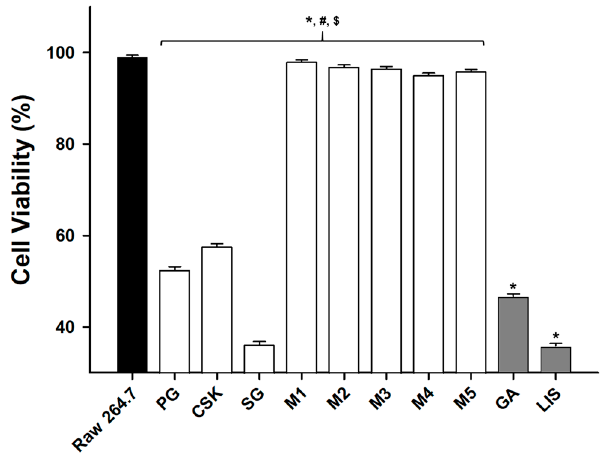
Figure 3. MTT assay statistical graph: xell viability. All experimental groups were compared with GA, LIS, and RAW 264.7 cell (control). * vs Con. p < 0.01, # vs GA. p < 0.01, $ vs LIS. p < 0.01.